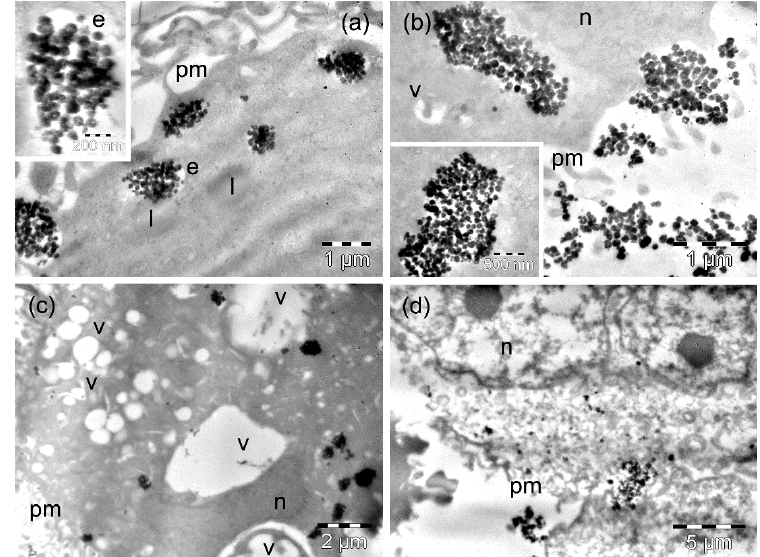
Figure 6. TEM images of MW35 cells containing MnFe 2 O 4 MNPs after 4 h ( a , b ) and 24 h ( c , d ) of incubation time. The letters n, e, v, l, and pm denote the nucleus, the endosomes, the vacuoles, the lipid droplets, and the plasma membranes, respectively. The inset in ( a ) on the left shows the formation of an endosome with Mn 2 Fe 3 O 4 MNPs.